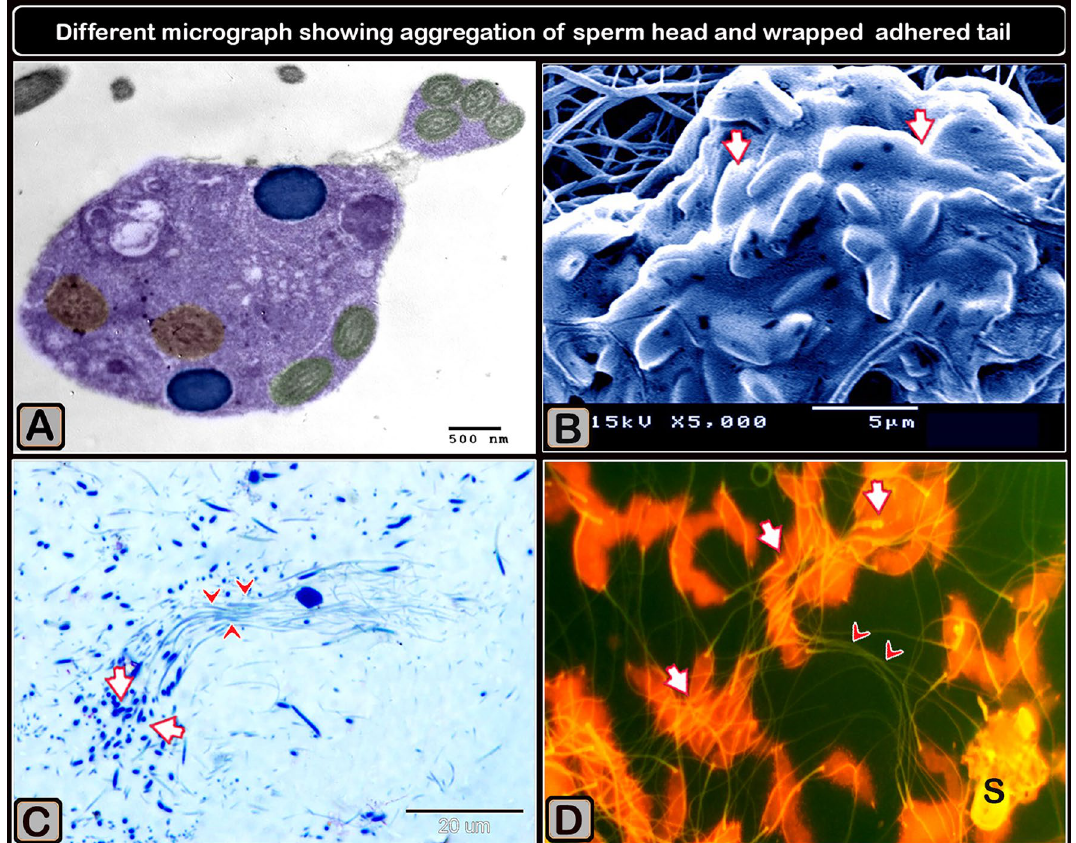
Figure 5. Digitally colored transmission electron micrographs demonstrating connected tails in a sperm bundle and agglutination material connecting sperm heads. ( A ) Adhered sperm tails from numerous sperms. Note of how the tail appears in longitudinal (arrows) and transverse (arrowheads) views. ( B ) The sperm’s head (arrowhead) is linked to the tail (arrow). ( C ) Several sperm tails attached (arrowheads). ( D ) Agglutination material (AS, blue color) connects four sperm heads (violet